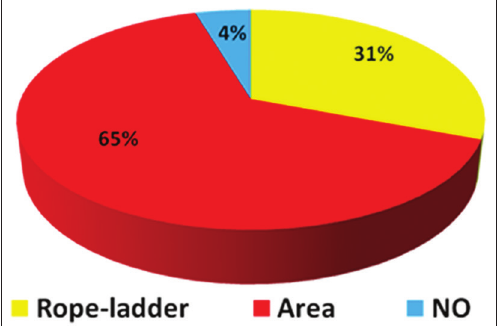
FIGURE 2. Cannulation techniques in vascular access.